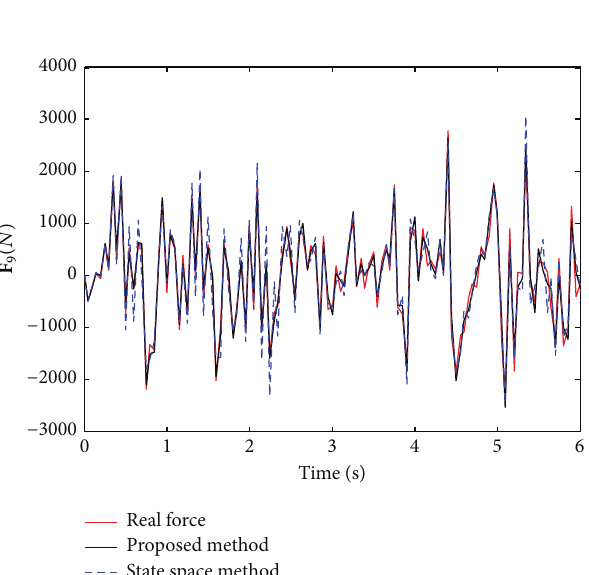
Figure 8: Force identification results of F 5 .